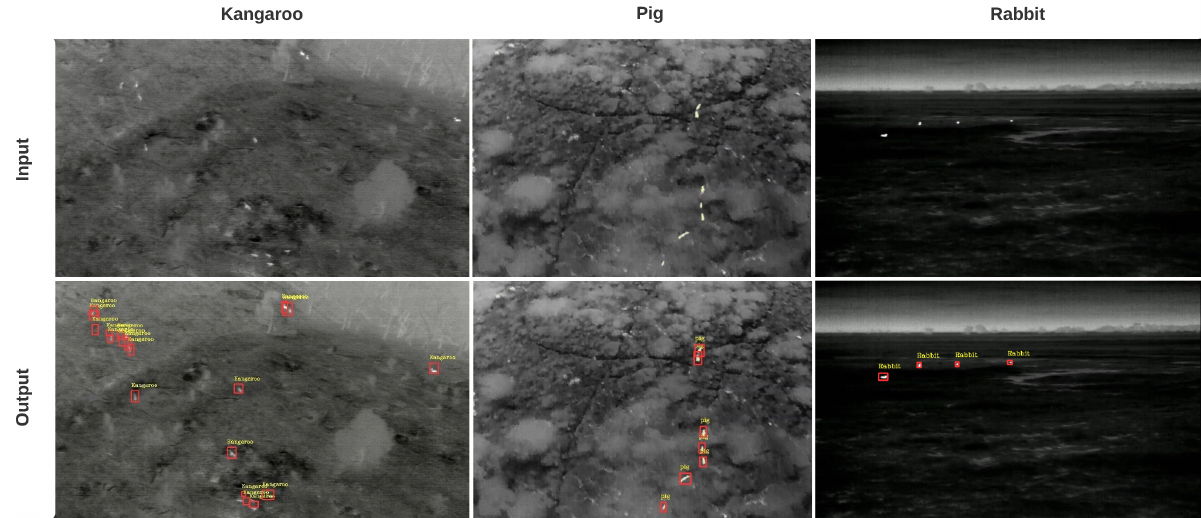
Figure 10. Sample Results: the first row includes input images, while the second row shows respective output images. Both bounding boxes and labels are